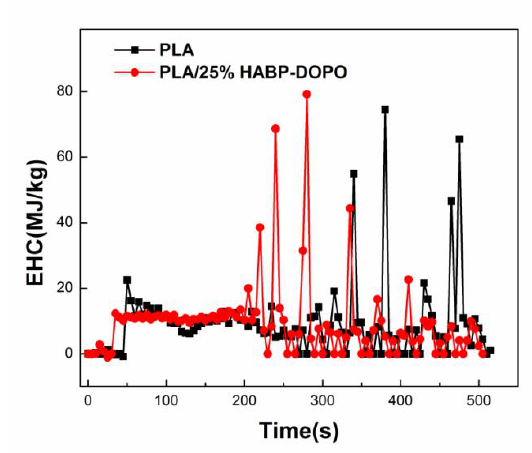
Figure 12. E ff ective heat of combustion (EHC) curves of PLA and PLA / HABP-DOPO blends. Figure 12. Effective heat of combustion (EHC) curves of PLA and PLA/HABP-DOPO blends.